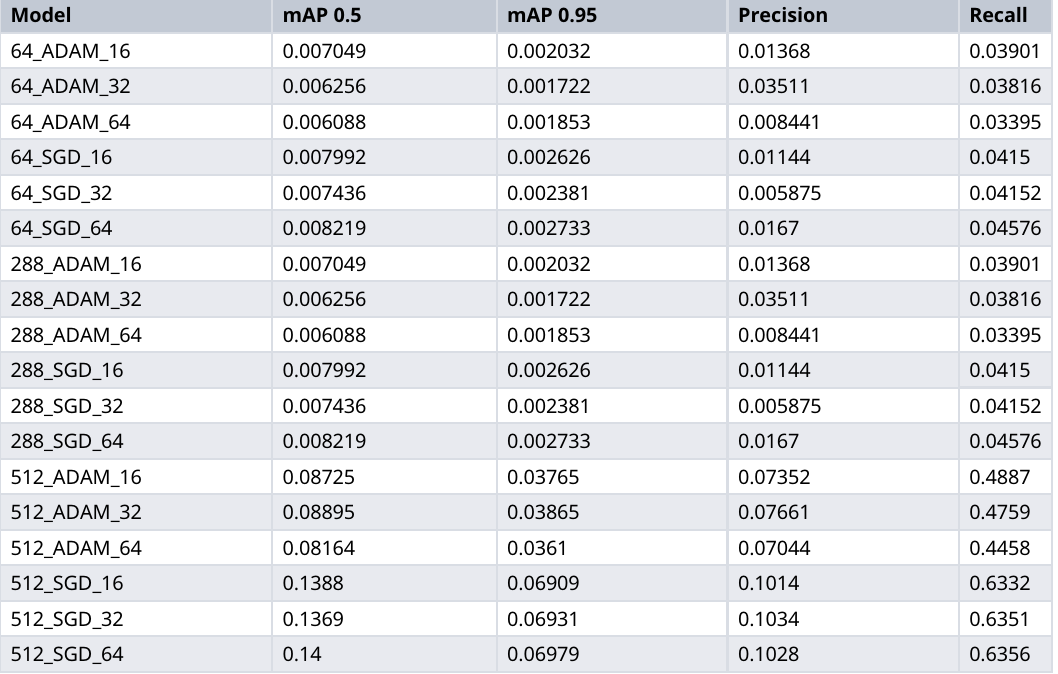
Table1. Performancematrixfordifferenthyperparameters. mAP0.5andmAP0.95 refertothemeanaverage over IoU thresholds of 0.5 and 0.95, respectively.